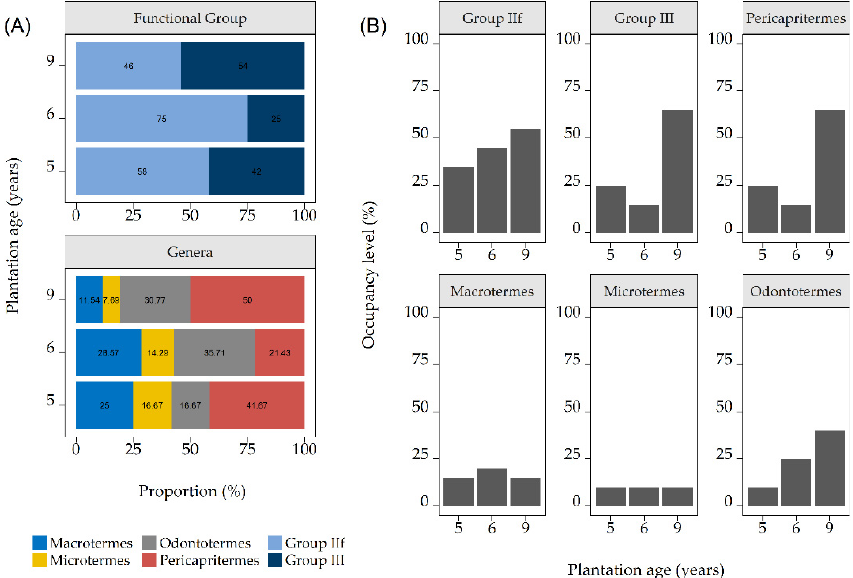
Figure 2. Termite assemblage based on ( A ) proportion and ( B ) occupancy in three teakwood plan- tations. The denominators used to calculate the proportions were the total numbers of genera and functional groups observed during the study; for occupancy, it was the total number of plot sections per plantation (20